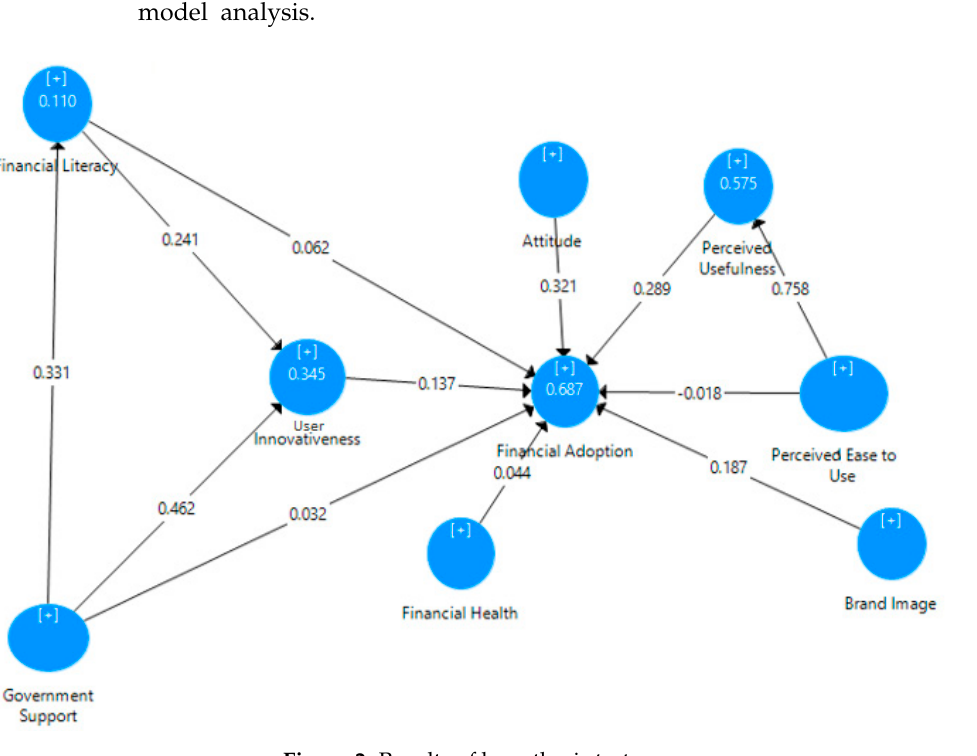
Figure 2. Results of hypothesis tests. Table 8. Hypothesis Testing.